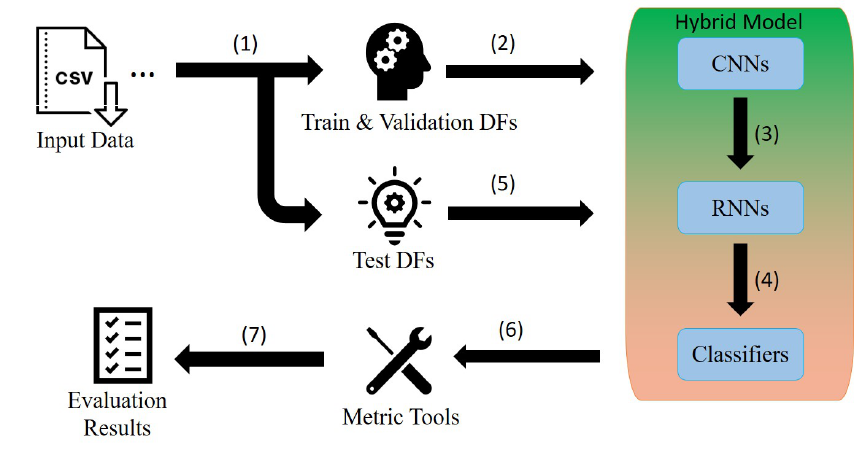
Figure 1. A schematic view of the analysis